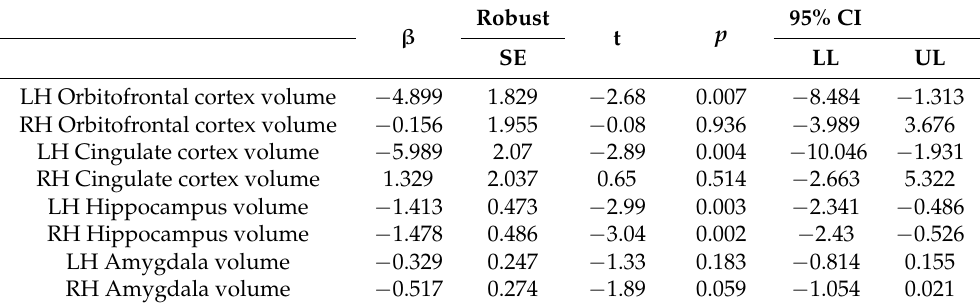
Table 3. Associations between parental externalizing behavior and children’s limbic brain structures volume (mm 3 ) *. β